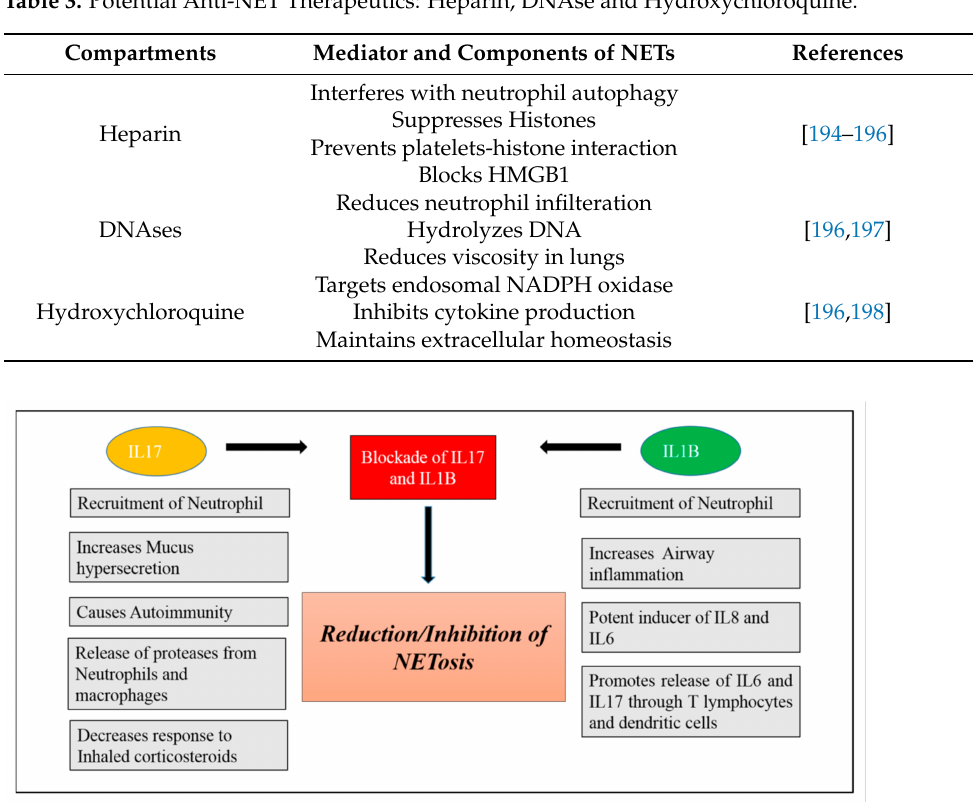
Figure 4. Flow chart showing the potential Anti-NET Therapeutics targets by blockade of IL17 and